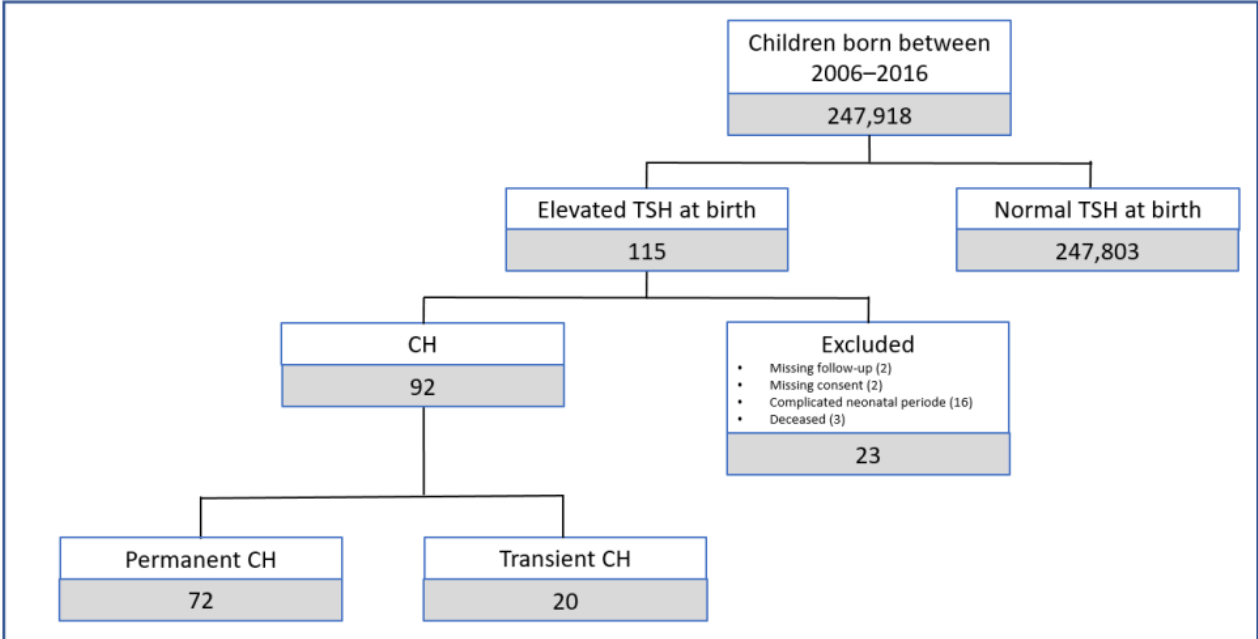
Figure 1. Number of patients included and excluded from the study.